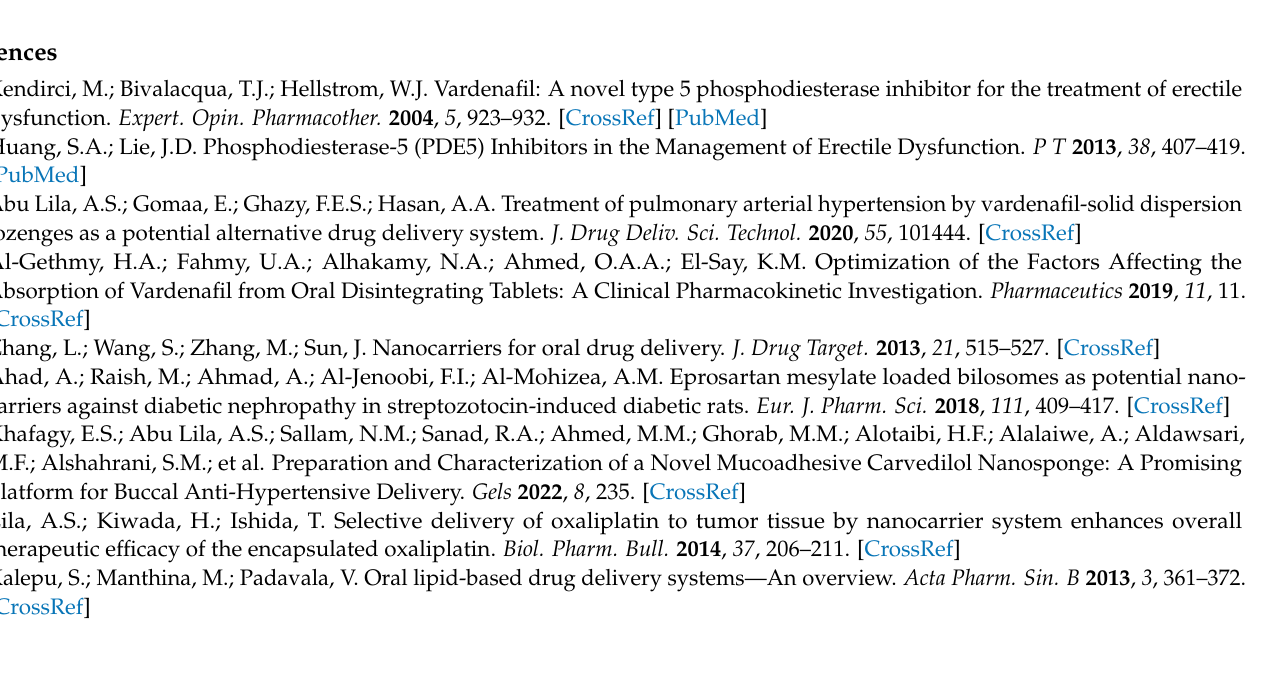
Table S2: Stability study for optimized VDF-loaded bilosomal